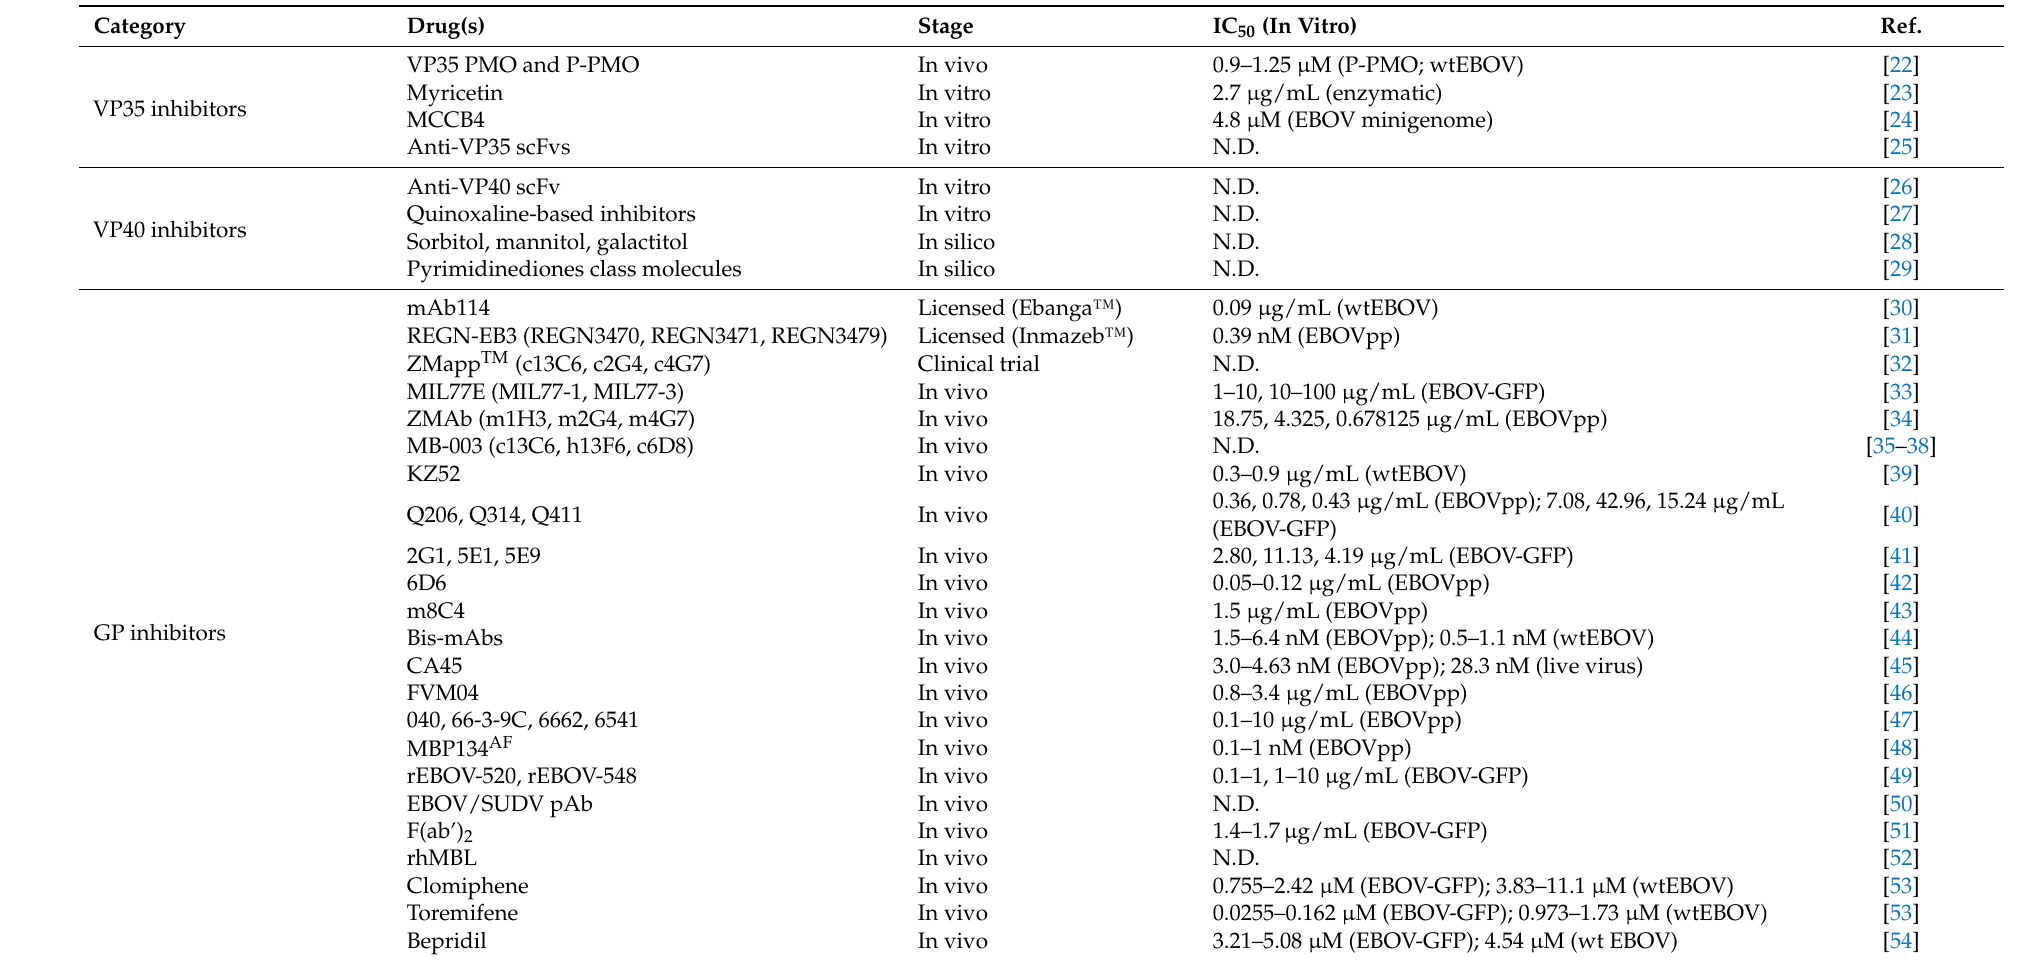
Table 1. Potential antiviral candidates against EBOV